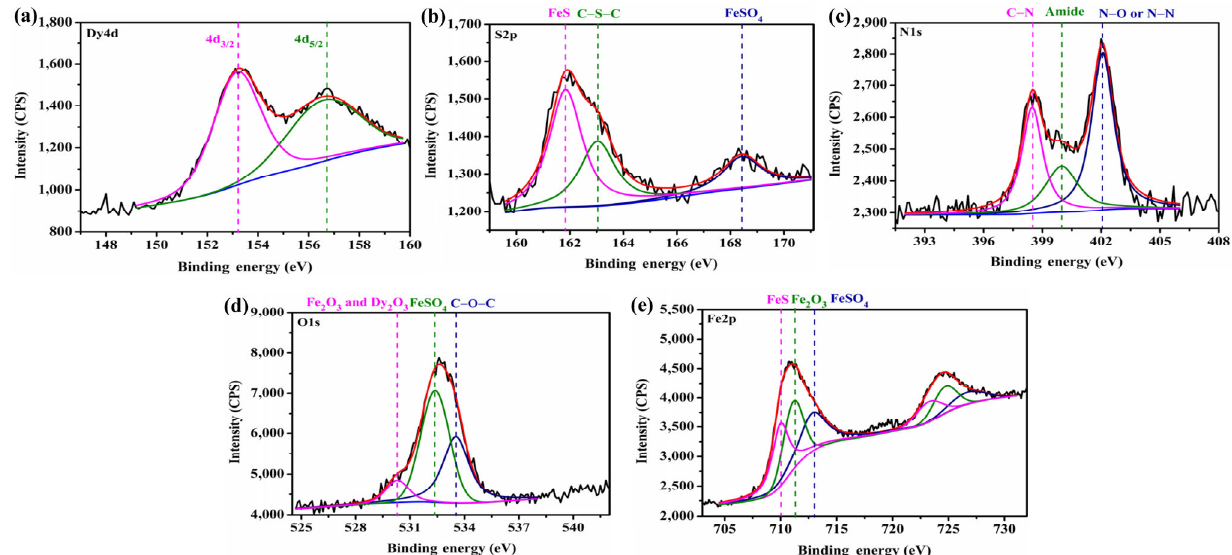
Fig. 17 Curve-fitted XPS spectra of the worn steel surface under MIL lubrication at 150 ° C and 100 N: (a) Dy4d, (b) S2p, (c) N1s, (d) O1s, and (e)